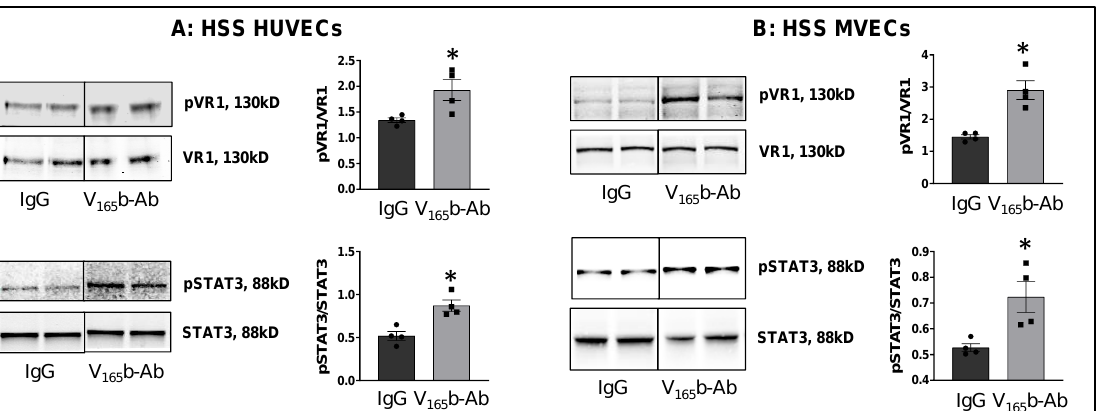
Figure 2. VEGF 165 b inhibition decreases VEGFR2 signaling in vitro and in vivo : Immunoblot analysis of pVR2(Y1175)/VR2, pAKT/AKT, pERK/ERK, peNOS/eNOS in ( A ) HSS-HUVECs treated with IgG or VEGF 165 b-Ab for 24 h. n = 3. Unpaired t-test. ( B ) HSS-MVECs were treated with IgG or VEGF 165 b- Ab for 24 h. n = 4, Unpaired t -test. ( C ) Immunoblot analysis of pAKT/AKT, pERK/ERK, pe- NOS/eNOS in Balb/c mice ischemic muscle treated with IgG or VEGF 165 b-Ab at day 3 post-HLI. n ≥ 5. Unpaired t -test. * p < 0.05 considered significant. Data Mean ± SEM.